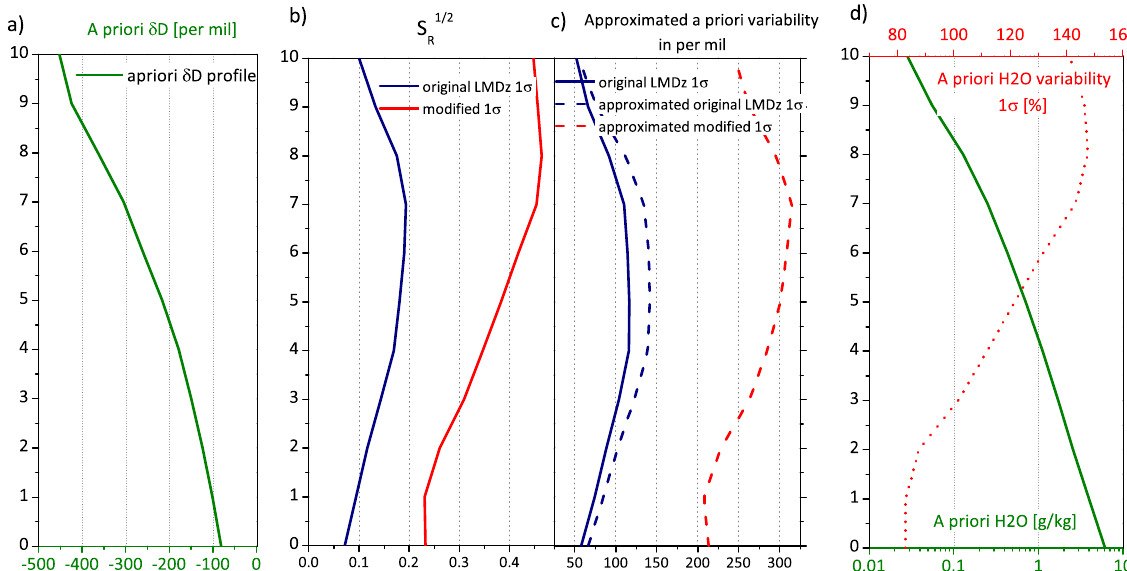
Fig. 2. Description of a priori information. (a) A priori δ D profile. (b) Log(HDO/H 2 O) variability (1 σ ) that originally comes from the LMDz simulations (blue line) and Log(HDO/H 2 O) variability (1 σ ) applied in the retrievals (red line) after modification (see details in the text). (c) Exact variability that originally comes from the model in per mil (blue line) and approximated (dashed blue line). Approximated 1 σ variability introduced in the retrieval after the modification (dashed red line). (d) A priori H 2 O profile (green line) and its 1 σ variability expressed in % (dashed red